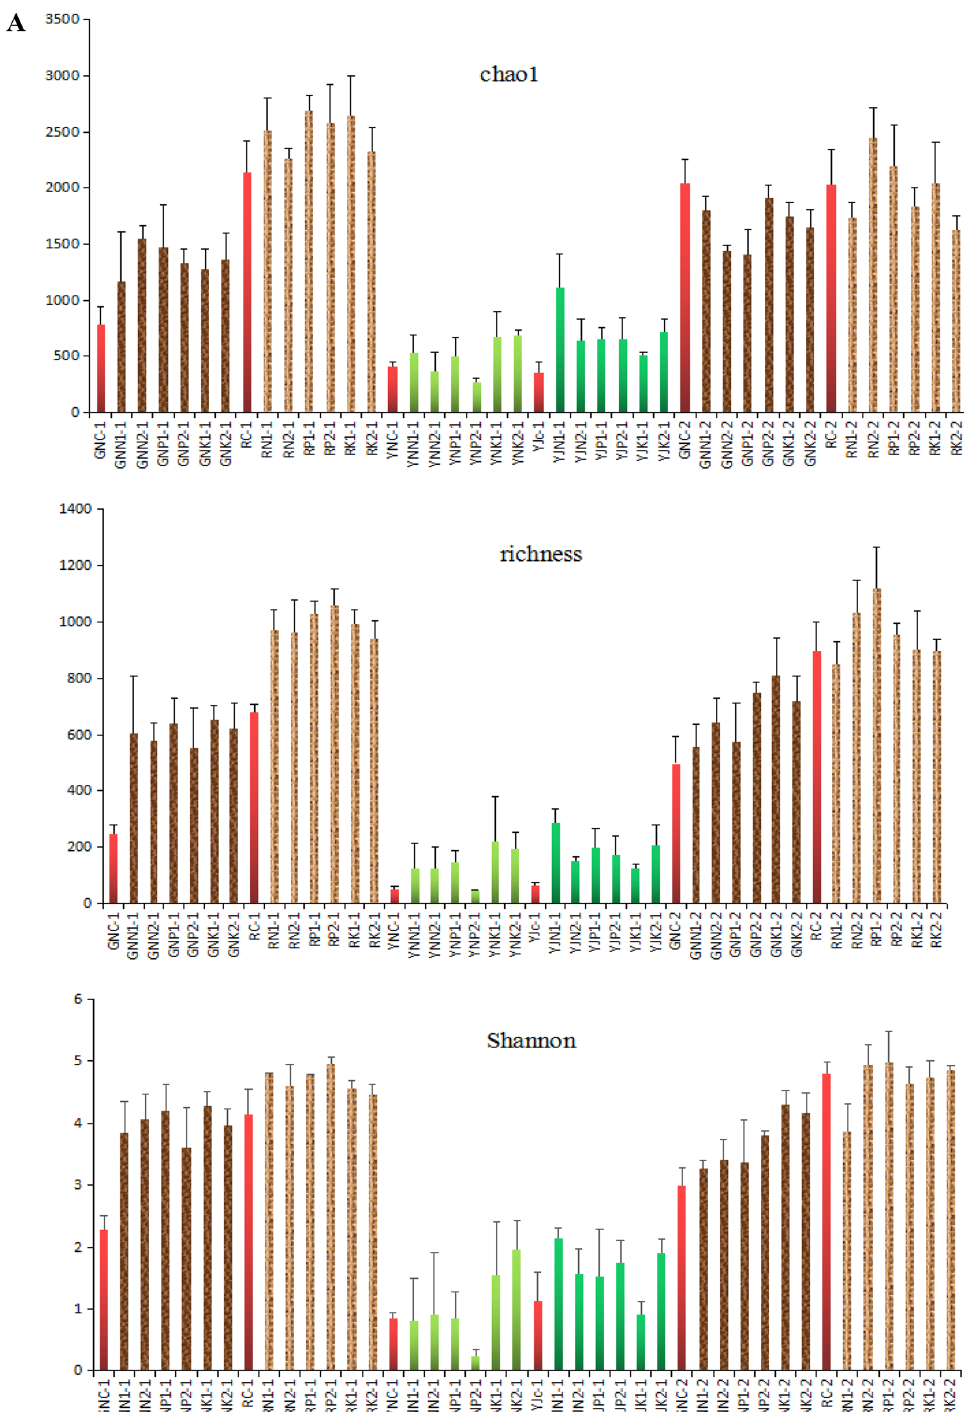
Figure 6. ( a ) α-diversity (chao-1, richness, Shannon) of bacteria in root, rhizosphere, leaf, and phyllosphere of rice at tillering stage and maturity stage. ( b ) α-diversity (Inv_simple, Pielou_evenness, Simpson_evenness) of bacteria in root, rhizosphere, leaf and phyllosphere of rice at tillering stage and maturity